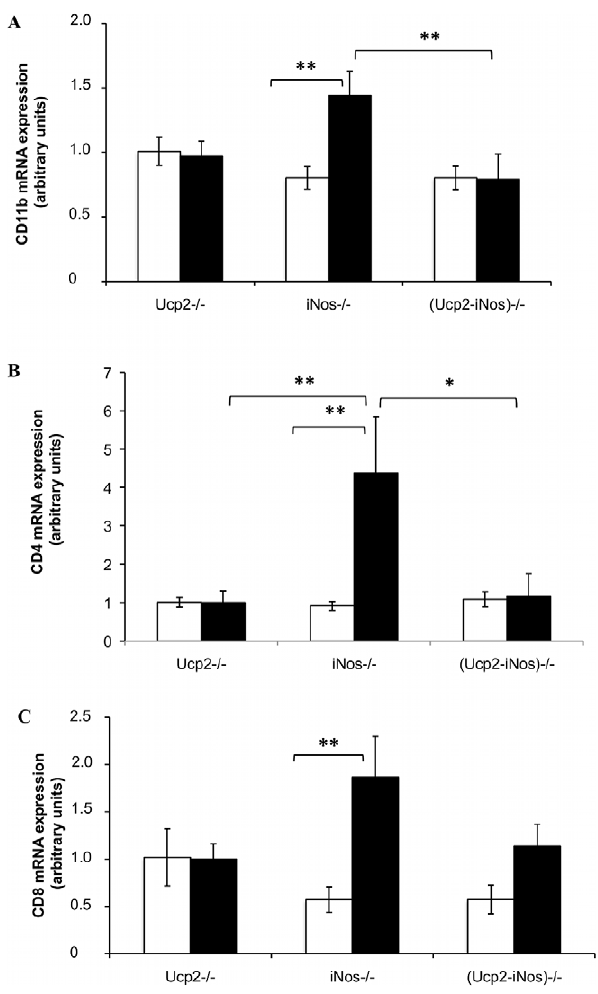
Figure 2. Infiltration of immune cells in the central nervous system. Both brain and spinal cord from MOG immunized mice of all genotypes were collected at days 10 (white) and day 14 (grey). Levels of mRNAs specific for the monocyte cell marker CD11b (A), and for the T cell markers CD8 (B) and CD4 (C) were assessed by real time quantitative RT-PCR. The data are expressed as the relative mean 6 SEM of 9–12 mice per genotype using GADPH as the housekeeping gene. Statistical significance was determined by ANOVA. *, P , 0.05; **, P , 0.01; ***, P , 0.001.